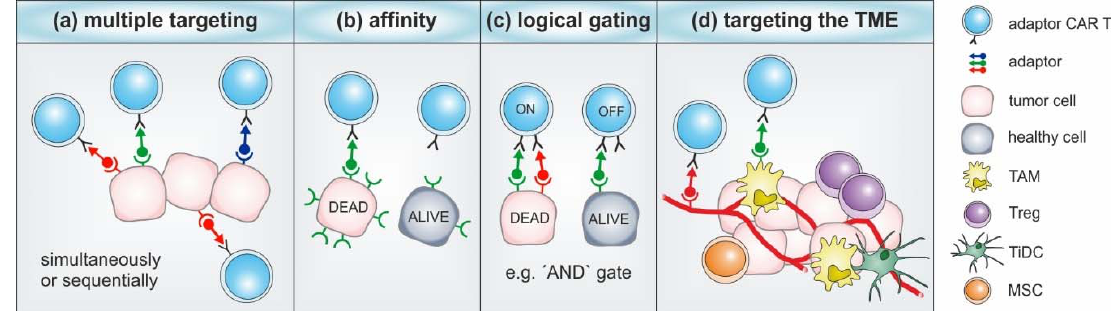
Figure 4. Flexibility and specificity of adaptor CAR systems. ( a ) Adaptor CAR T cells can be redirected either simultaneously or sequentially to multiple targets via different adaptor molecules. ( b ) By